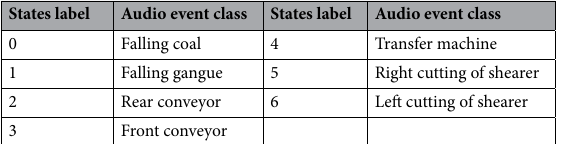
Table 2. Description of noiseless dataset for coal-gangue